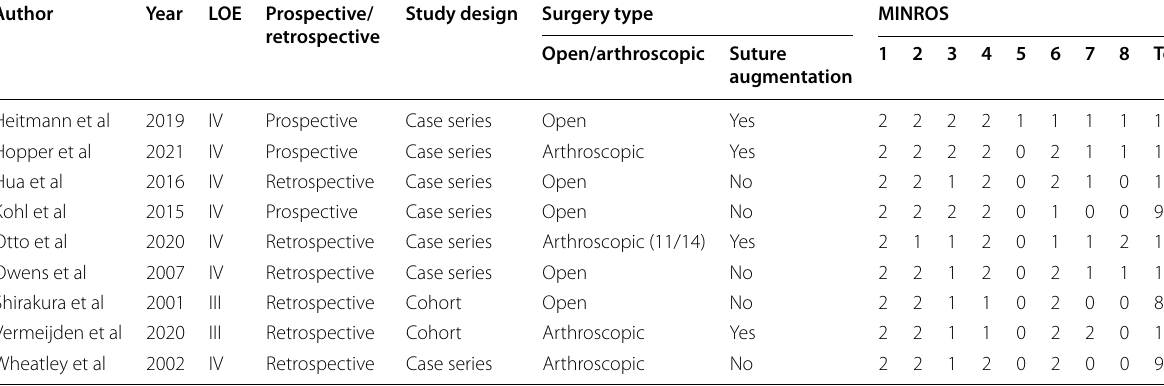
LOE Level of evidence, MINORS Methodological Index for Non-randomized Studies The 8 items of the MINORS; 0